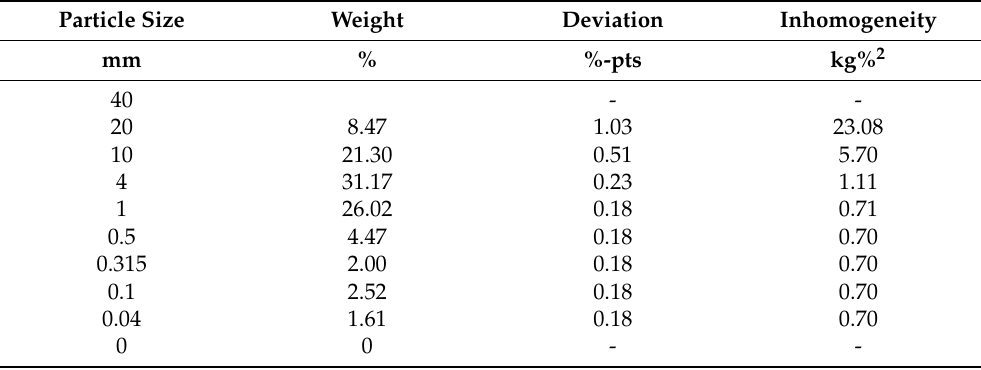
Figure 7. Particle size distribution ( A ). Correlation between particle size and density of particles − 40 mm ( B ). Waste dump: A = “Altstefanie, H = “Matthäus”, and K = “Glück”. Figure 7B presents the mean densities of the particle size fractions of − 40 mm. As Table 5. Result of the sieve analysis using the example of “A1 top” with indication of the deviation shown in this plot, the mean densities increase steadily with a decreasing particle size with a statistical certainty of 95% and the corresponding inhomogeneity. until they peak either at 100–315 µm or 40–100 µm. This indicates a higher content of heavy minerals in these particle sizes. The subsequent lower density in the fines is caused by the Particle Size Weight Deviation Inhomogeneity presence of organic matter. The removal of organic matter is quite easy with particles of mm % %-pts kg% 2